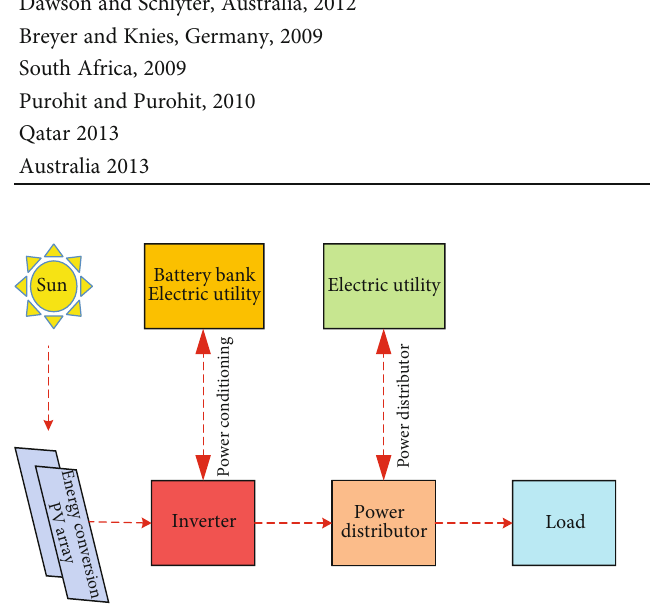
Figure 7: PV systems convert solar energy into electrical power with various